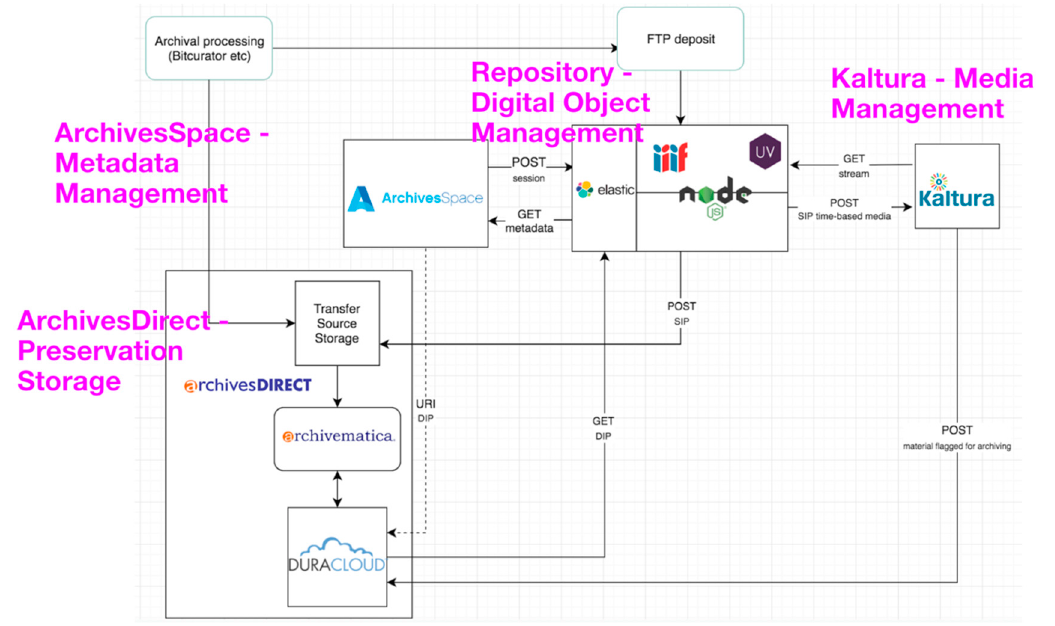
Figure 1. The digital collections ecosystem, an integrated infrastructure of open-source systems and microservices.